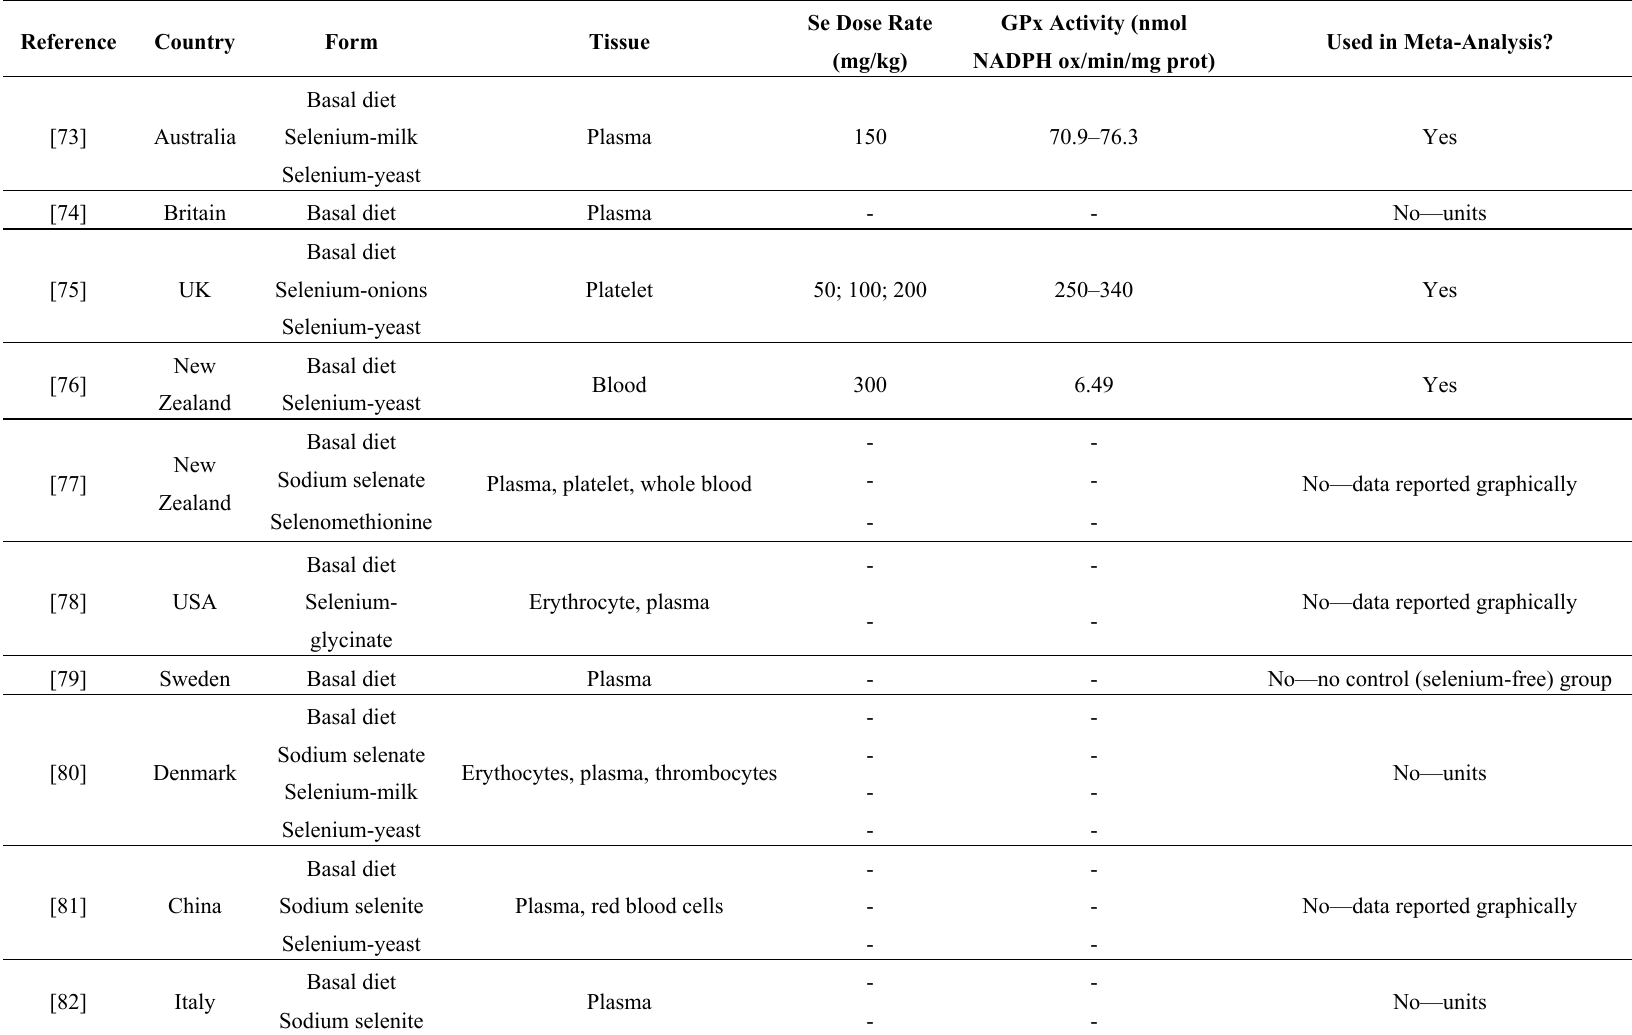
Table 4. Description of the country, form of selenium studied for selenoprotein activity with changing concentrations of selenium in the diet for investigated in human